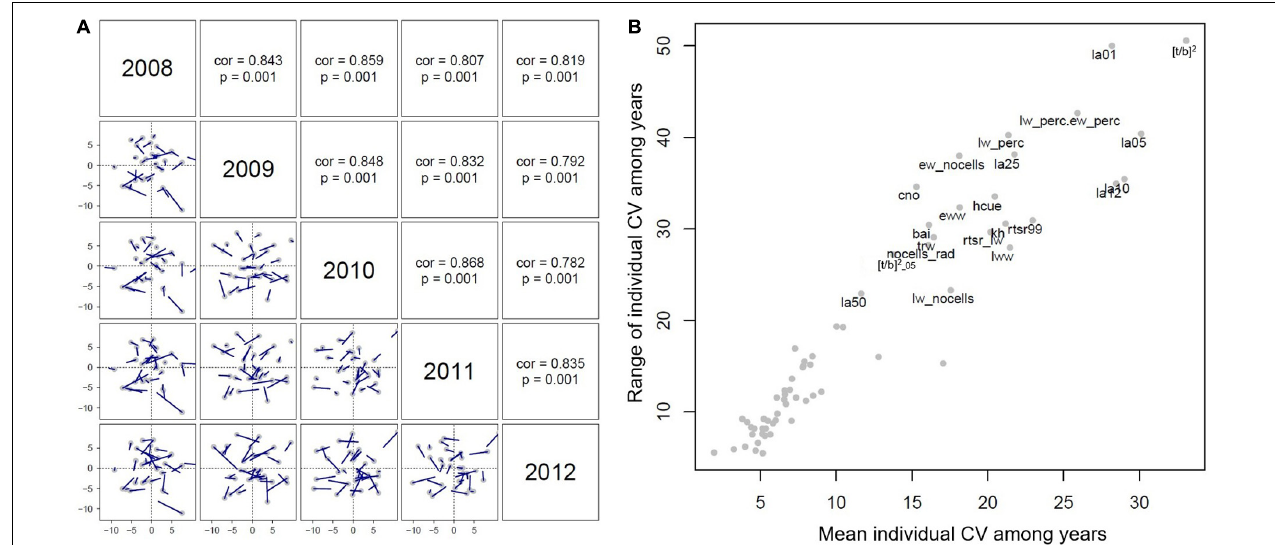
FIGURE 8 | (A) Results from the Procrustes test analyzing the stability of PC scores through time. Correlation coefficients and their statistical significance are shown in panels above the diagonal. Blue lines represent shifts in the position of individual trees among years. (B) Mean and range of individual coefficient of variation (CV) among years for each anatomical trait. Traits characterized by large variation among years were